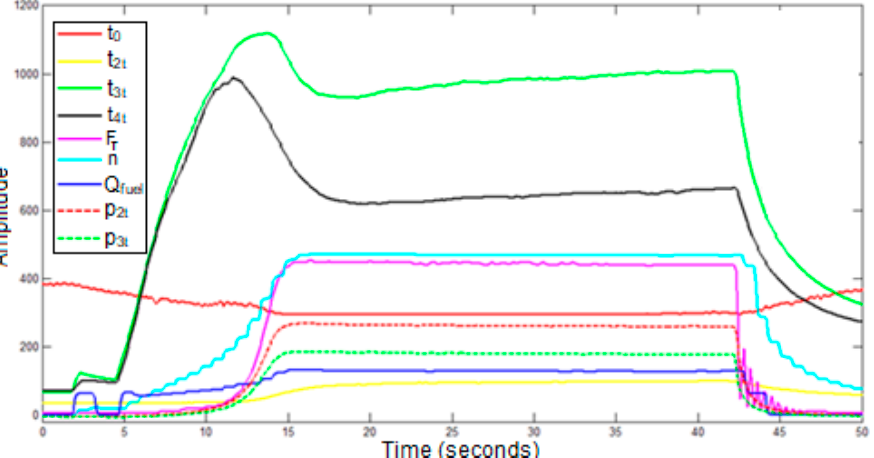
Figure 8. Graphic course of changes in SJE-20 parameters when using a mixture of 60% Jet A-1 aviation kerosene and 40% FAME biofuel at an engine temperature of 70.1 °C. Table 10. Mixture of 60% Jet A-1 aviation kerosene and 40% FAME biofuel, 1st launch (40th second).